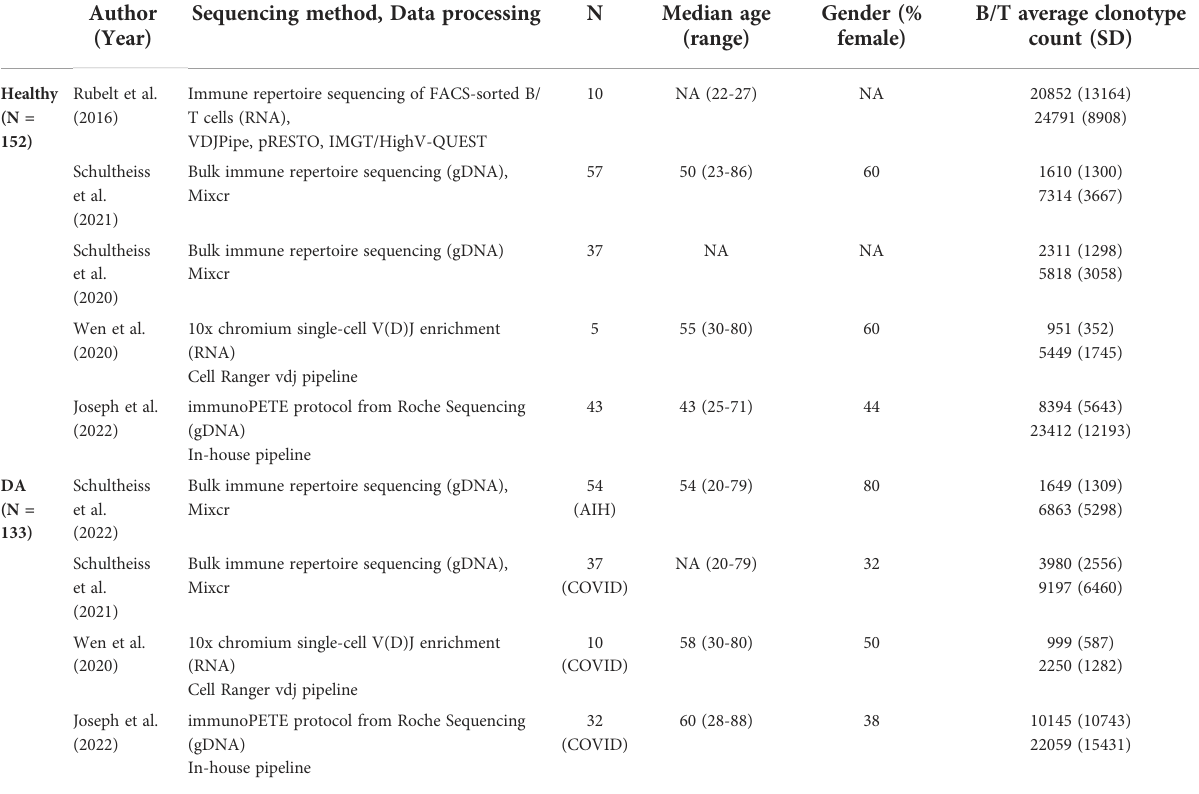
TABLE 1 Demographic and sequencing information on the studies with immune repertoire data from both B and T cells used for